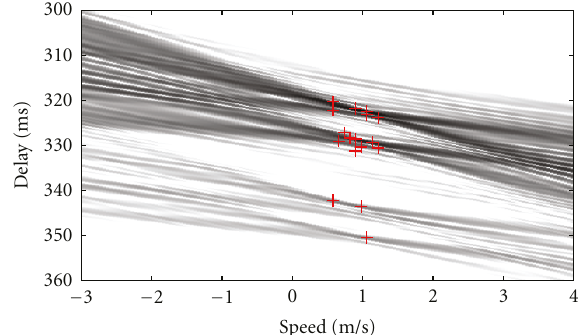
Figure 17: Wideband ambiguity function of the received LFM signal in the BASE07 experimental data. The crosses represent the maxima detected after the first 20 MPD